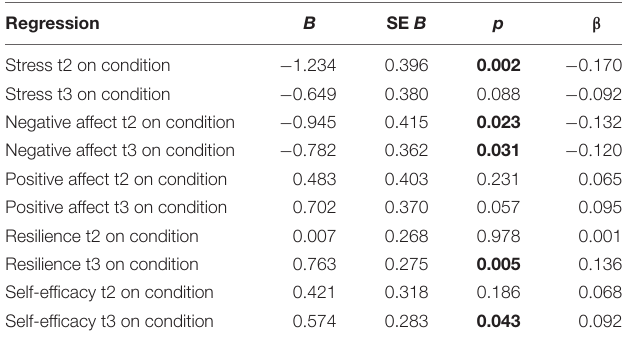
TABLE 2 | Unstandardized and standardized coefficients, standard errors, and p -values of the regressions. Regression B